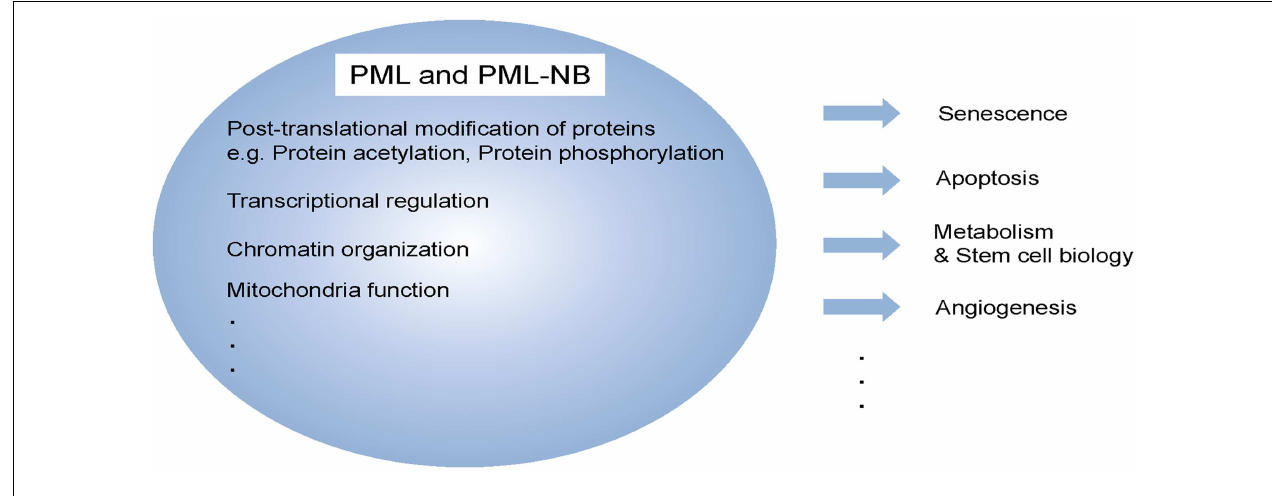
functions are achieved by different biochemical means such as post-translational modification, transcriptional regulation as well as mitochondria